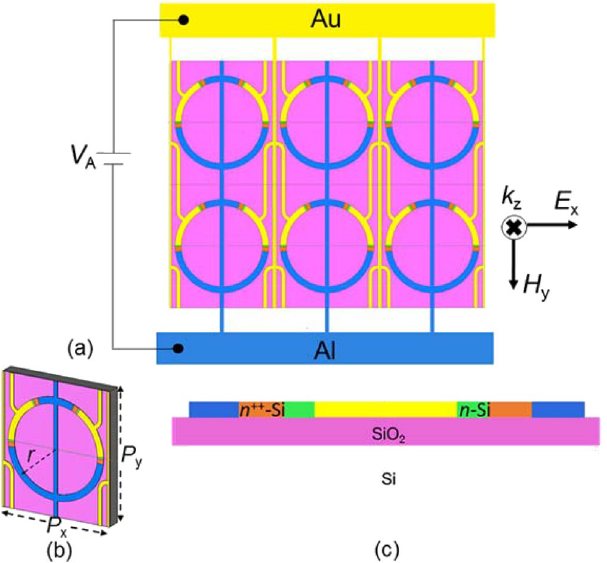
Figure 1. ( a ) A schematic top ( x–y ) view of the metasurface THz modulator with local and global interconnects and bias pads; ( b ) a 3D representation of the unit cell constituting the metasurface; ( c ) a 2D side ( r-z plane) view of the unit cell, rotated to show the two adjacent (of four) Schottky diodes about a single Au gate